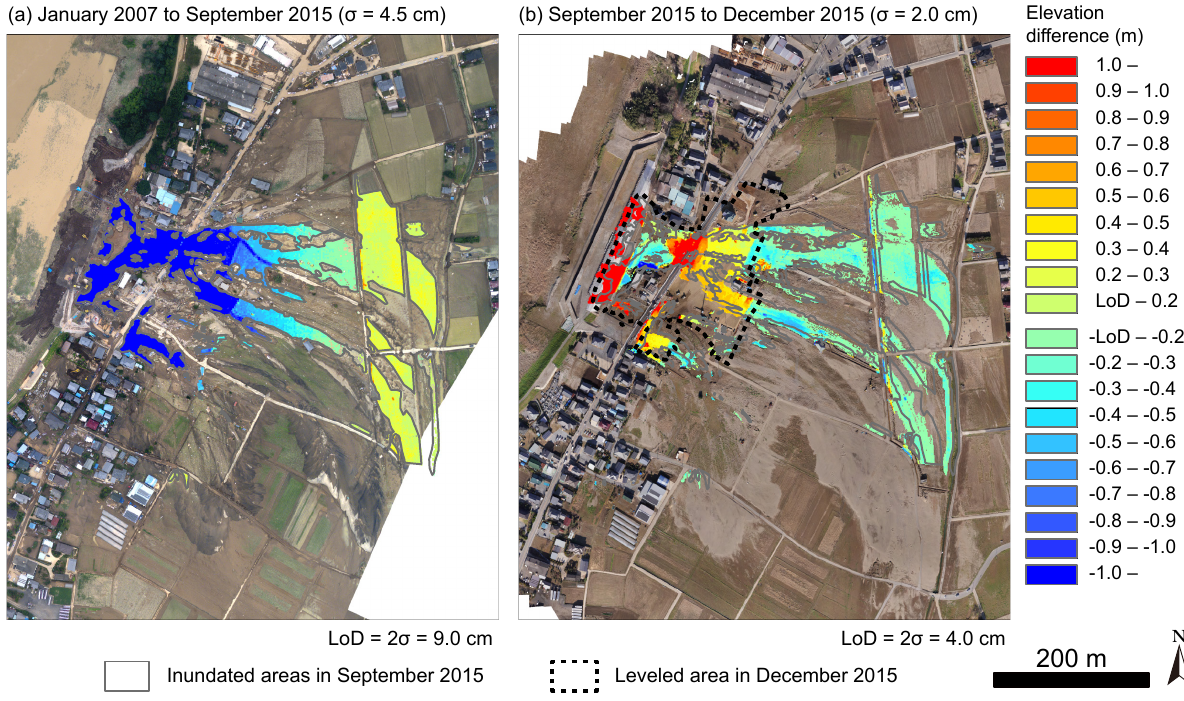
Figure 7. Differential rasters indicating the elevation differences between two successive snapshots after the removal of the systematic error in the adjustment of resolution in the areas inundated in September 2015. (a) The January 2007 DSM subtracted from the September 2015 DSM. Note that erosion near the breached levee was more than 1m. (b) The September 2015 DSM subtracted from the December 2015 DSM. The elevation changes within the dashed line do not represent water depths because artificial land filling has been done.